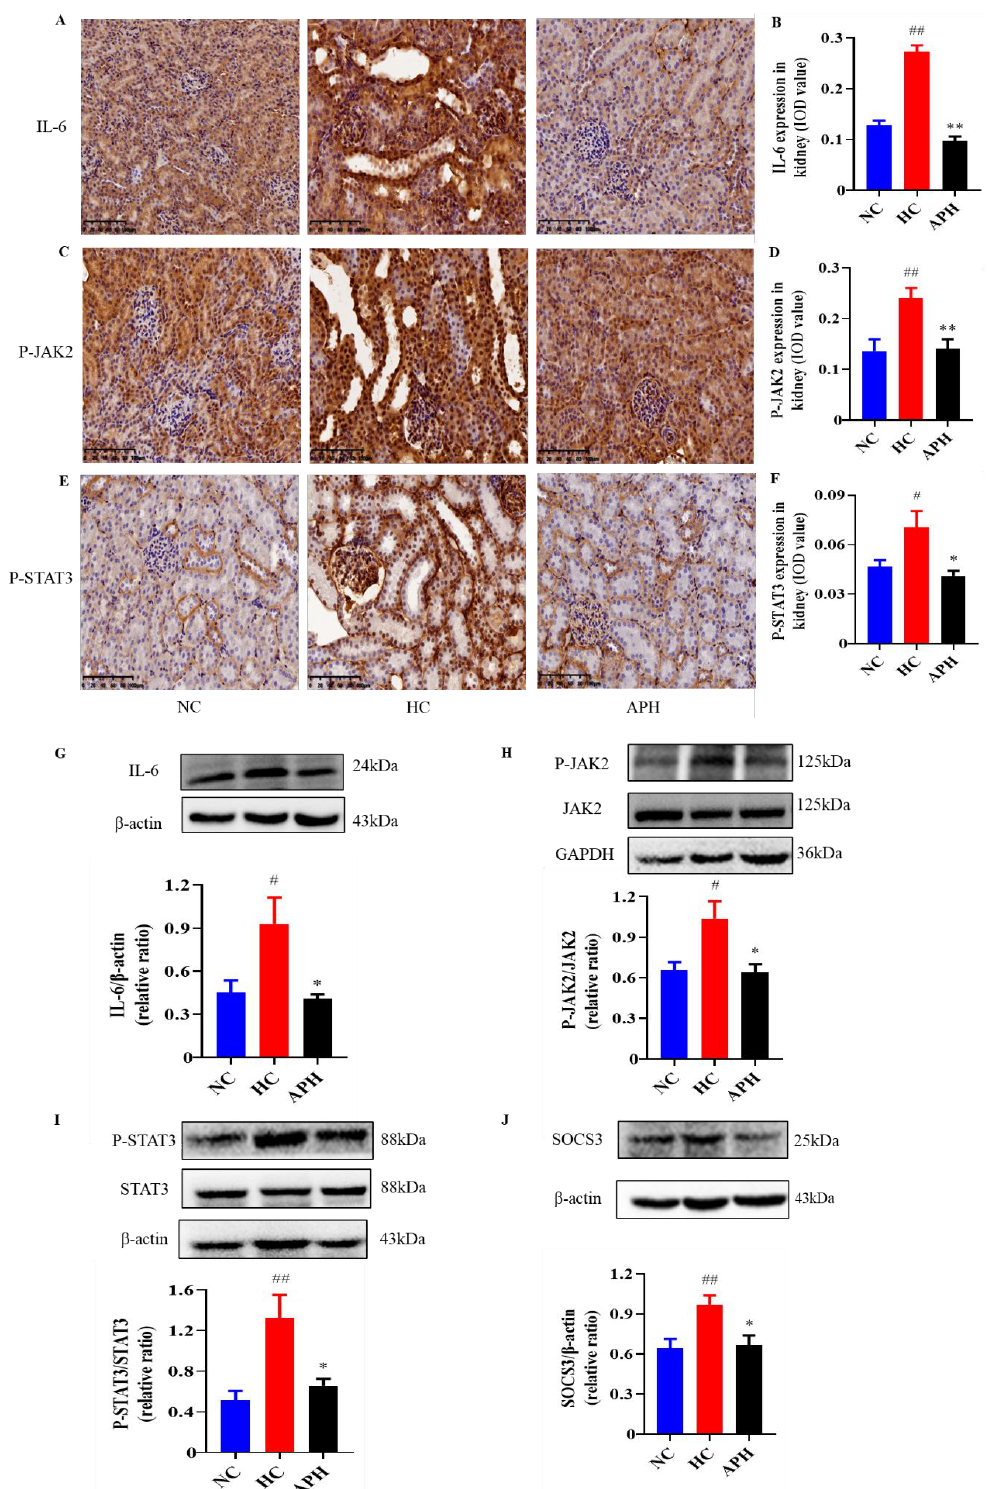
Figure 7. Apigenin reduces the expression levels of IL-6, P-JAK2, P-STAT3, and SOCS3 in the kidneys of HUA mice. Representative images of IHC staining ( × 200, Scale bar: 100 µ m) and their analyses show IL-6 ( A , B ), P-JAK2 ( C , D ), and P-STAT3 ( E , F ) expressions in the kidneys ( n = 5). Representative images of western blots and their analyses show IL-6 ( G ), P-JAK2 ( H ), P-STAT3 ( I ), and SOSC3 ( J ) expressions in the kidneys ( n ≥ 3). ## p < 0.01, # p < 0.05 vs. the NC group. ** p < 0.01, * p < 0.05 vs. the HC